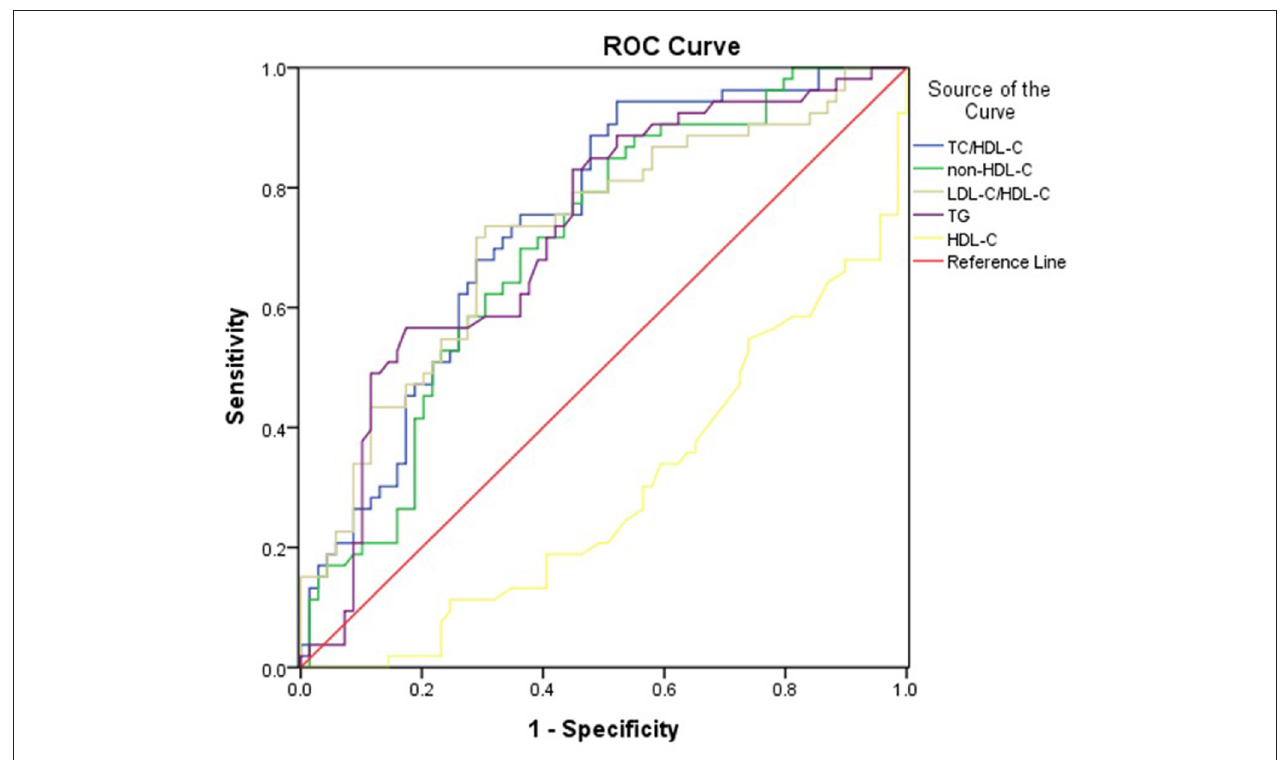
FIGURE 1 | Area under the receiver operating characteristics curves (AUROCs) of lipid markers for the severity of